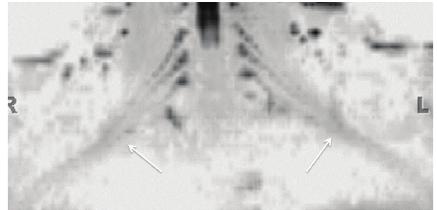
Figure 7: 3D functional nerve selective MRN-Coronal MIP (inverted grey scale contrast) from a 3D DTI using single shot EPI ( 𝑏 value 0, 800, 1000s/mm 2 and 12 directions of interrogation) shows the symmetrical normal appearance of bilateral brachial plexuses (arrows). However, notice the decrease in SNR as compared to diffusion weighted imaging as shown in Figure 5.